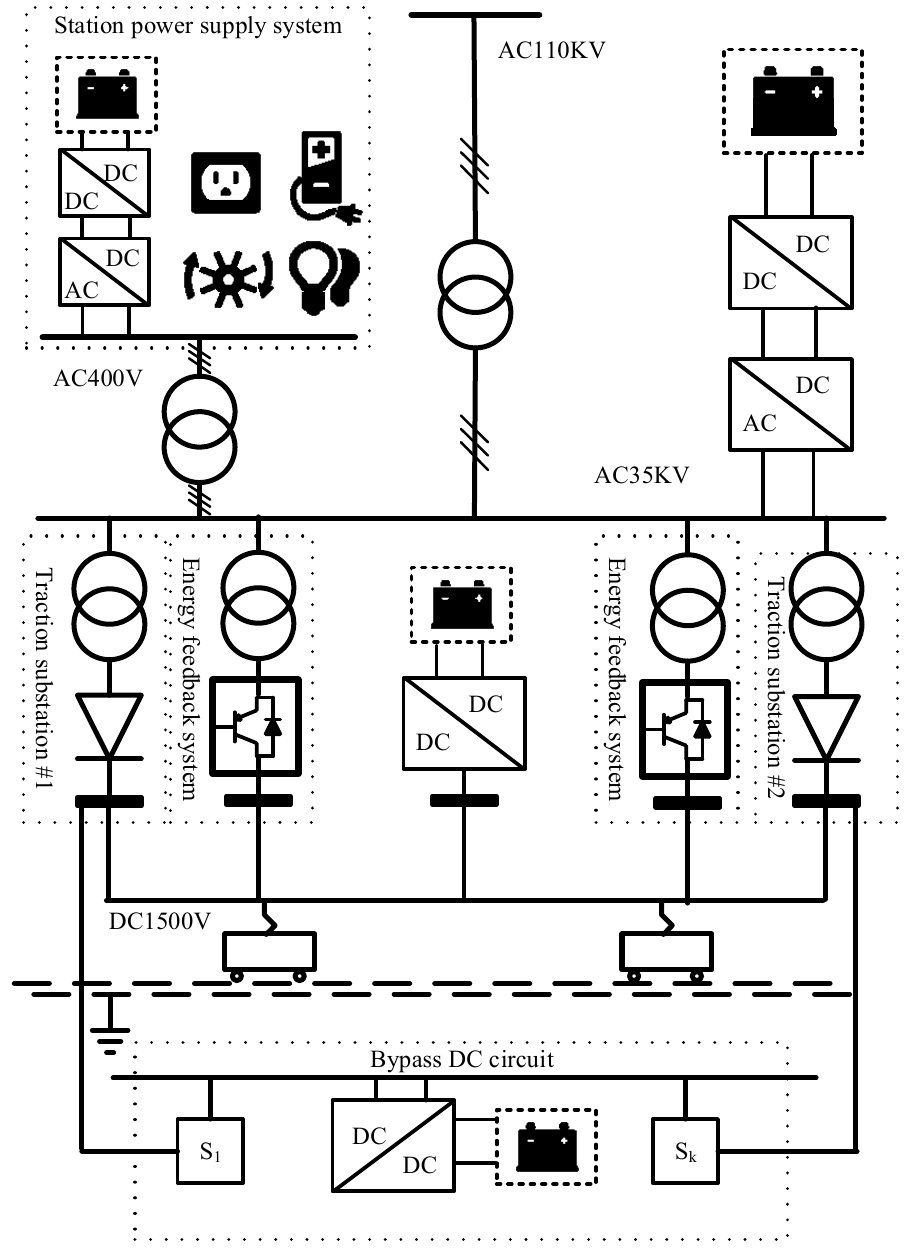
Figure 2. The DC traction energy system topology. The AC traction network is the typical traction grid structure of railways. The AC traction power network supplies the trains via AC busbars based on traction transformers. The traction transformer is a step-down transformer as the grid supplying the traction system has voltage levels of 110 kV, 220 kV, and 330 kV, and the trains are supplied at 27.5 kV. There are three common forms of traction transformer wiring: v / v transformers, SCOTT transformers, and YNd11 transformers [19,20]. Figure 3 shows the typical AC traction power network with multi-trains.